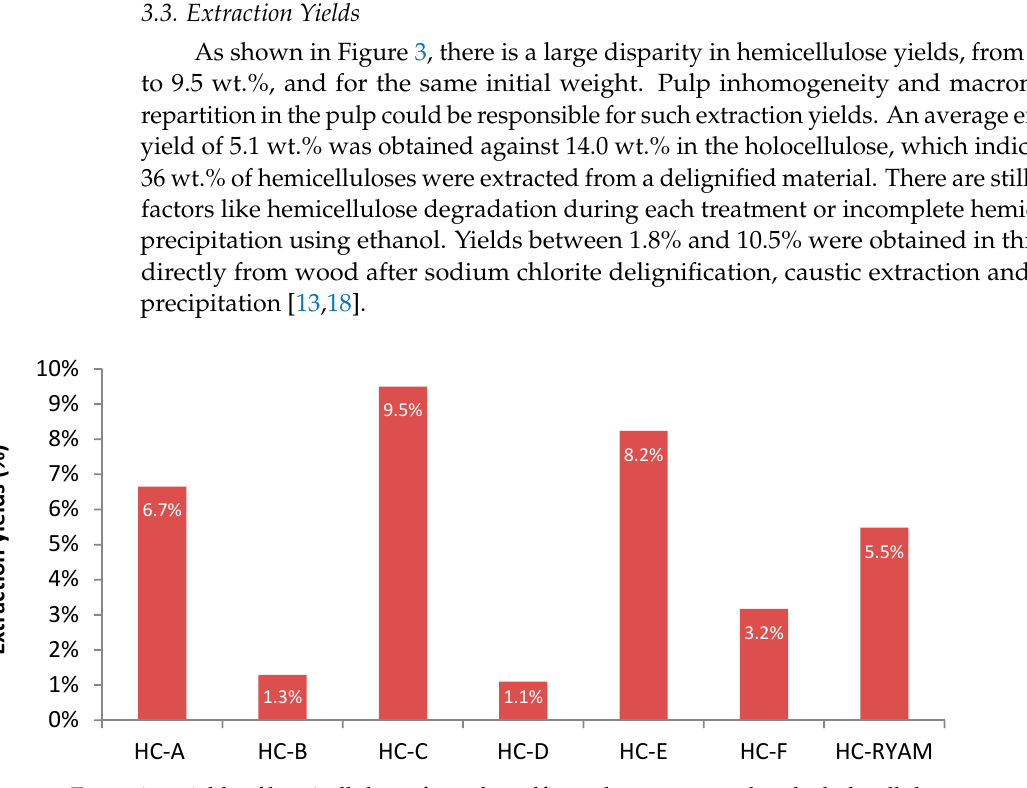
Figure 2. Evolution of the lignin and hemicellulose contents in pulps during extraction.